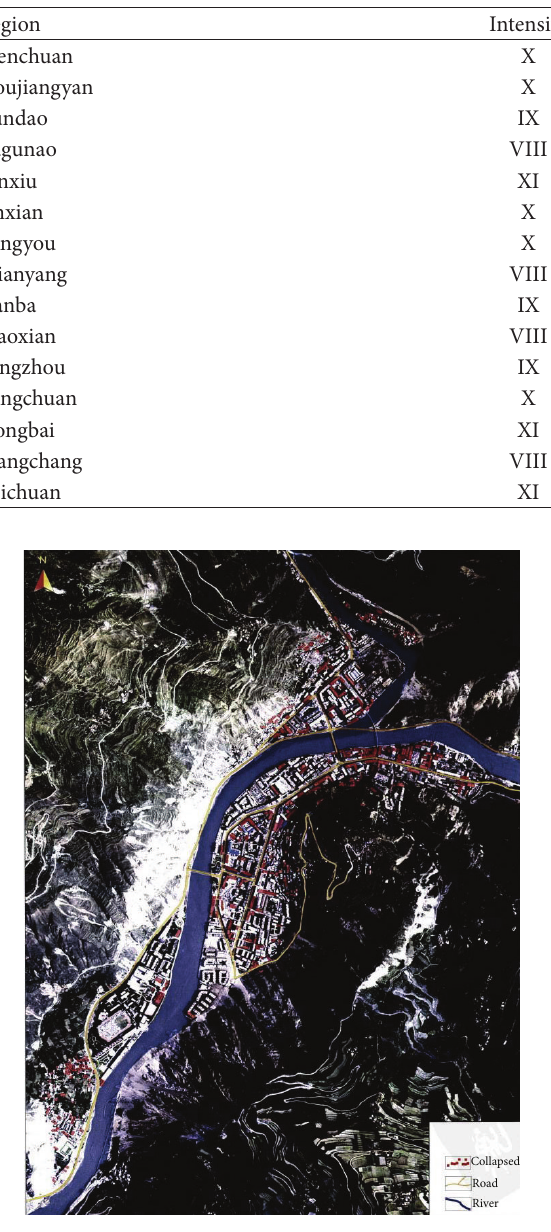
Table 3: Results of seismic intensity recognition.